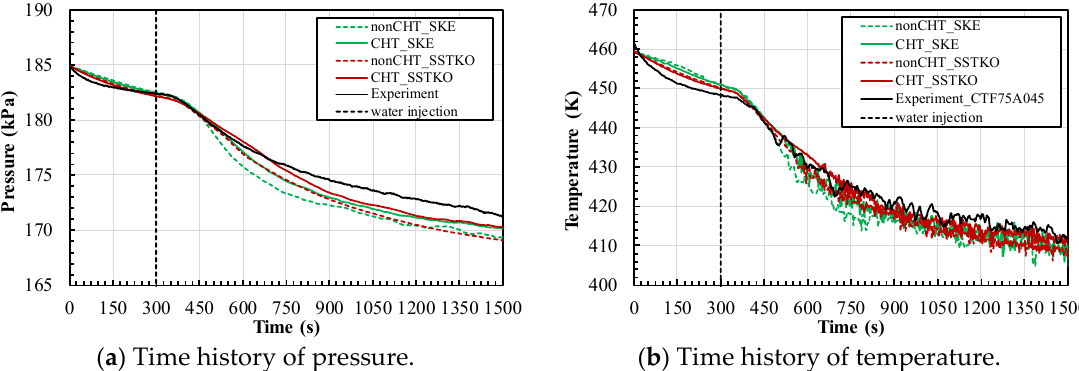
Figure 10. Time history of pressure and temperature as measured (black line) and numerically predicted by means of different turbulence models with CHT (solid lines) and without CHT (dash lines). Table 5 . Simulation model deviation from the measurement: effect of flat bars.